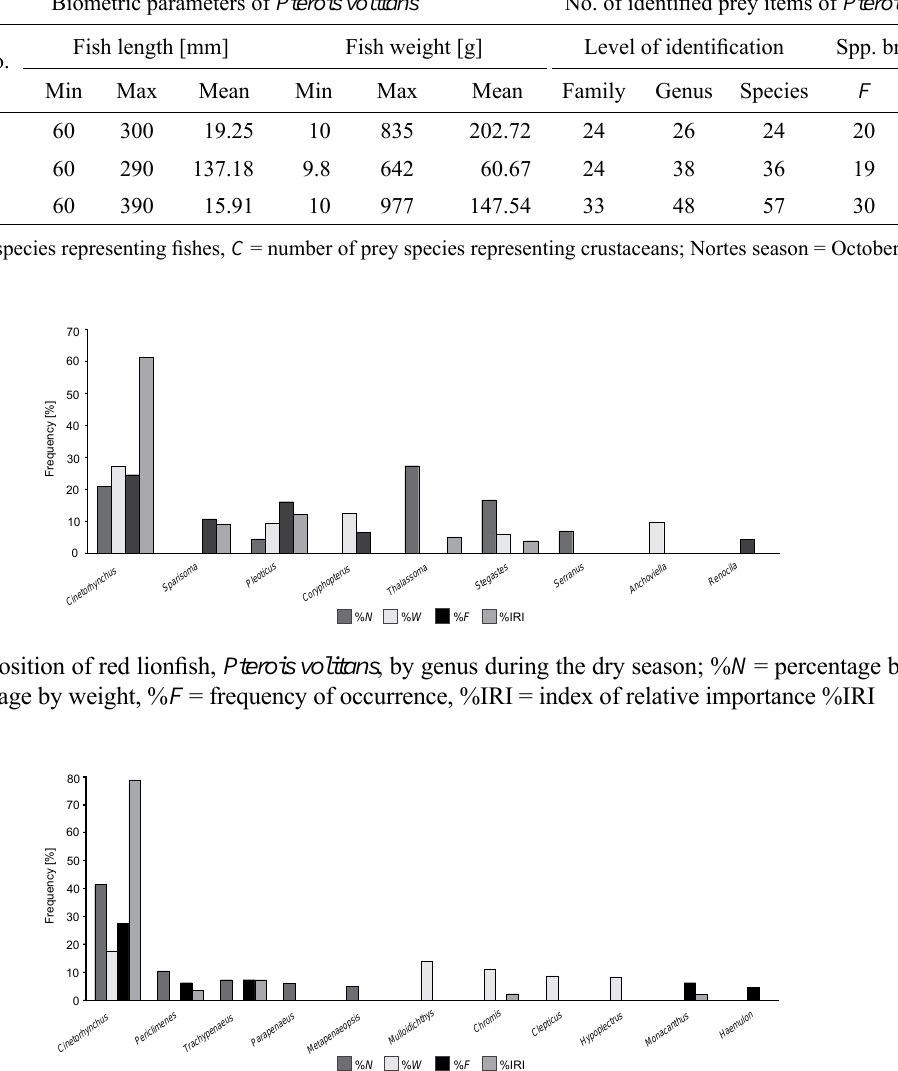
Basic biometric parameters of red lionfi sh, Pterois volitans , caught per season and number of its prey items representing different levels of identifi cation and different taxonomic groups